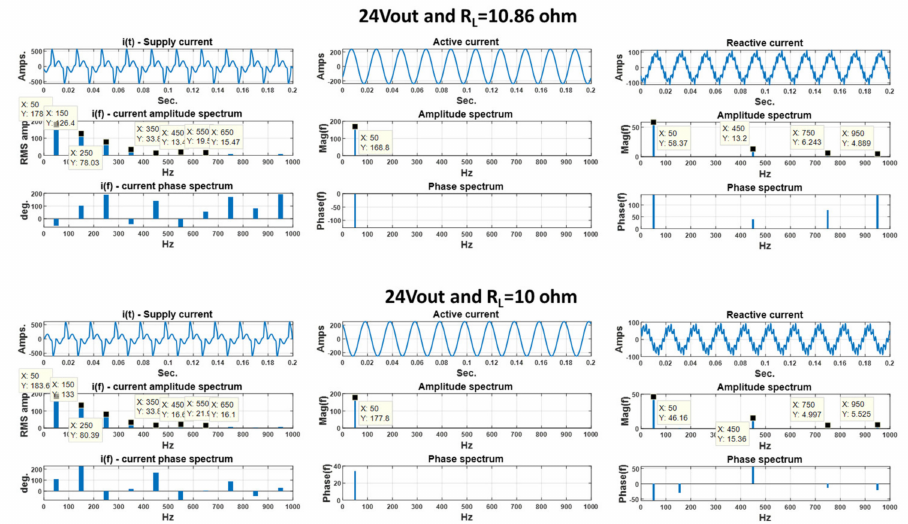
Figure 20. Loaded AC/DC converter: differences observed in CPC physical components at the same voltage and different output loads.